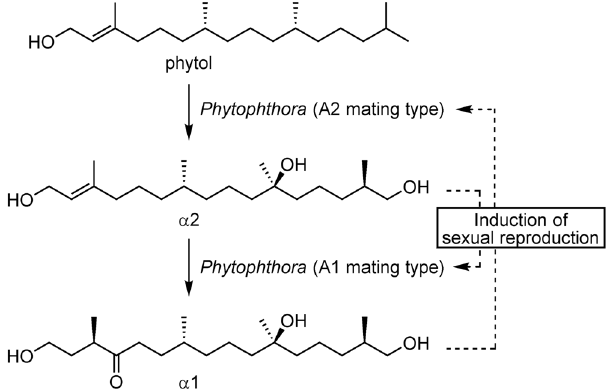
Figure 1. Mating hormones and induction of sexual reproduction in the plant pathogen Phytophthora . Regarding the coexistence of two mating types of Phytophthora , the A2 mating type converts phytol to α 2, which is then converted to α 1 by the A1 mating type. The secreted mating hormones α 2 (from A2) and α 1 (from A1) induce the sexual reproduction of the counter mating types A1 and A2,